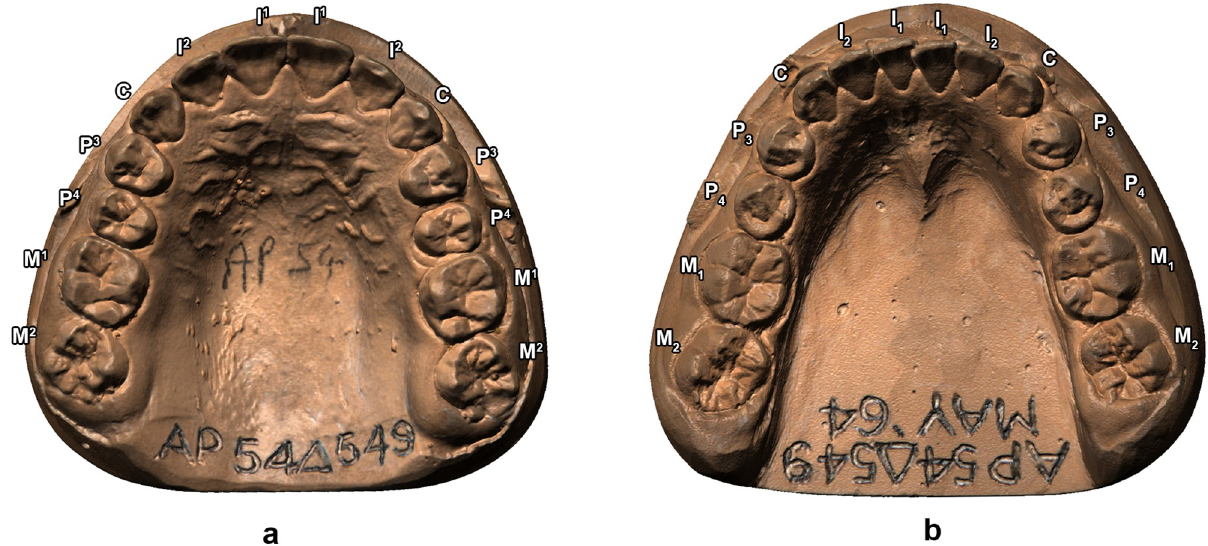
Fig 1. Three-dimensional digital models of upper (a) and lower (b) dental arches of a 12-year old Aboriginal child ( Δ 549). Images not to scale.